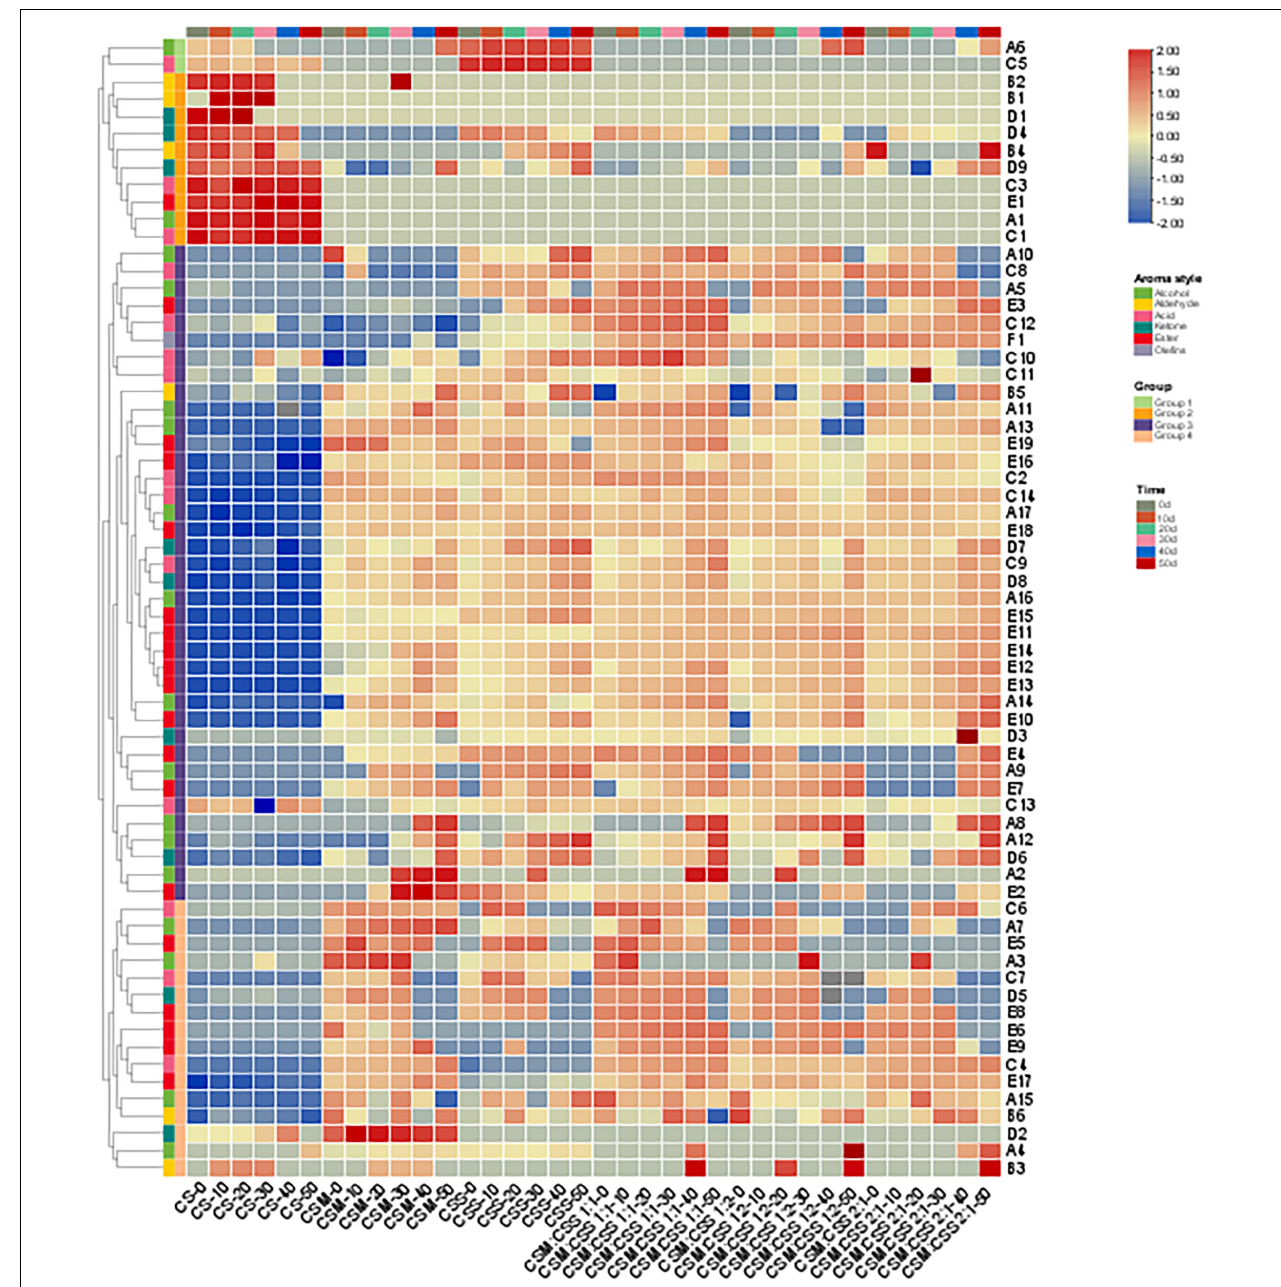
FIGURE 4 | Heatmap analysis of the contents of volatile components in cheeses during six fermentation periods (0, 10, 20, 30, 40, and 50 days). CS, CSM, CSS, CSM:CSS 1:1, CSM:CSS 1:2 and CSM:CSS 2:1 represent cheeses fermented using the commercial starter (Control group), K. marxianus B13–5, S. cerevisiae DL6–20, K. marxianus B13–5: S. cerevisiae DL6–20 1:1, K. marxianus B13–5: S. cerevisiae DL6–20 1:2, and K. marxianus B13–5: S. cerevisiae DL6–20 2:1. (A1. 2-Furanmethanol; A2. 1-nonanol; A3. 1-Octanol; A4. 2,3-Butanediol; A5. 3-Methyl-1-pentanol; A6. 1-Pentanol; A7. 2-Pentanol; A8. 1-Hexanol; A9. 3-(Methylthio)-1-propanol; A10. 1-Mutanol; A11. 2-Nonanol; A12. 1,2-Propanediol; A13. 2-Methyl-1-propanol; A14. 2-Heptanol; A15. 3-Methyl-2-butanol; A16. Benzene ethanol; A17. Iso amyl alcohol; B1. 2-Furan-carboxaldehyde; B2. 2-Hexenal; B3. Octanal; B4. Hexanal; B5. Nonanal; B6. Acetaldehyde; C1. 2-Ethyl-butanoic acid; C2. 2-Oxo-propanoic acid; C3. Pentanoic acid; C4. 2-Methyl-butanoic acid; C5. Propanoic acid; C6. Heptanoic acid; C7. Nonanoic acid; C8. 3-Methyl-butanoic acid; C9. Decanoic acid; C10. Butanoic acid; C11. Hexanoic acid; C12. Octanoic acid; C13. Acetic acid; C14. 2-Methyl-propanoic acid; D1. 3-Heptanone; D2. Dihydro-2-methyl-3(2H)-furanone; D3. 2-Octanone; D4. 2-Pentanone; D5. 2-Undecanone; D6. 1-Hydroxy-2-propanone; D7. 2-Heptanone; D8. 2-Nonanone; D9. 3-Hydroxy-2-butanone; E1. Acetic acid, methyl ester; E2. Pentanoic acid, ethyl ester; E3. Butanoic acid, pentyl ester; E4. Acetic acid, 2- methyl-propyl ester; E5. 1,2-Benzene dicarboxylic acid-bis(2-methylpropyl) ester; E6. Acetic acid, propyl ester; E7. Butyrolactone; E8. 9-Decenoic acid, ethyl ester; E9. Nonanoic acid, ethyl ester; E10. 2-Hydroxy-Propanoic acid ethyl ester; E11. Butanoic acid, ethyl ester; E12. Heptanoic acid, ethyl ester; E13. Decanoic acid, ethyl ester; E14. Hexanoic acid, ethyl ester; E15. 1-Butanol, 3- methyl-, acetate; E16. Acetic acid, butyl ester; E17. Acetic acid, 2-phenylethyl ester; E18. Octanoic acid, ethyl ester; E19. Acetic acid ethyl ester; F1. Benzene ethenyl).